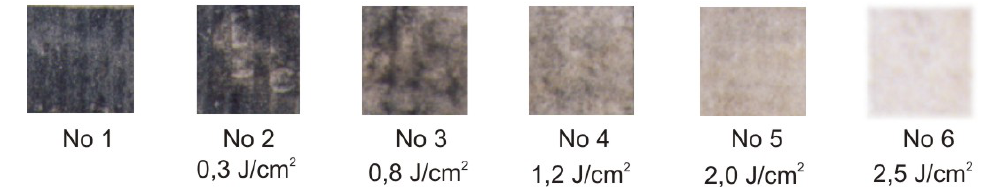
Figure 33. Illustration of successive stages of sandstone cleaning in dependence on irradiation